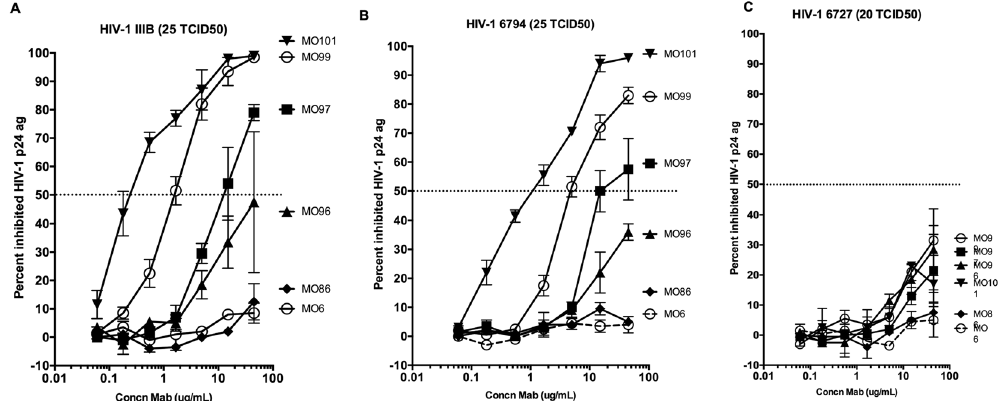
Figure 3. Neutralization of infectious cell-free HIV-1 with human IgM monoclonal antibodies and controls. The in vitro neutralizing Human anti-HIV-1 IgM MO101, MO97, and MO99, MO96 and the control non- neutralizing MO86 and MO6 with three HIV-1 isolates at equal virus concentrations (25 TCID59) ( A ) with HIV-1 IIIB in ( B ) with HIV-1 6794 isolate and in ( C ) with HIV-1 6727 isolate. The 50% inhibited HIV-1 p24 detection is indicated with the dotted line.